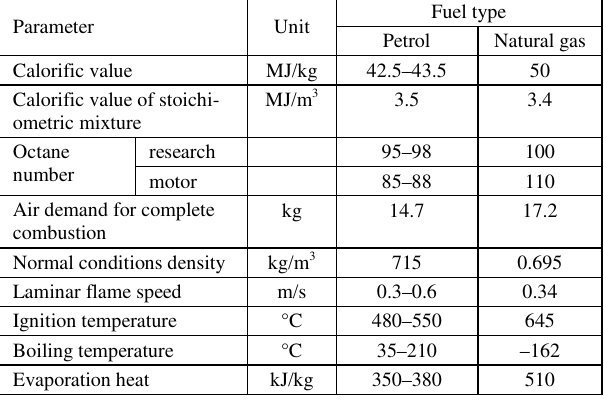
Table 2. Selected properties of petrol and natural gas – comparison [3,